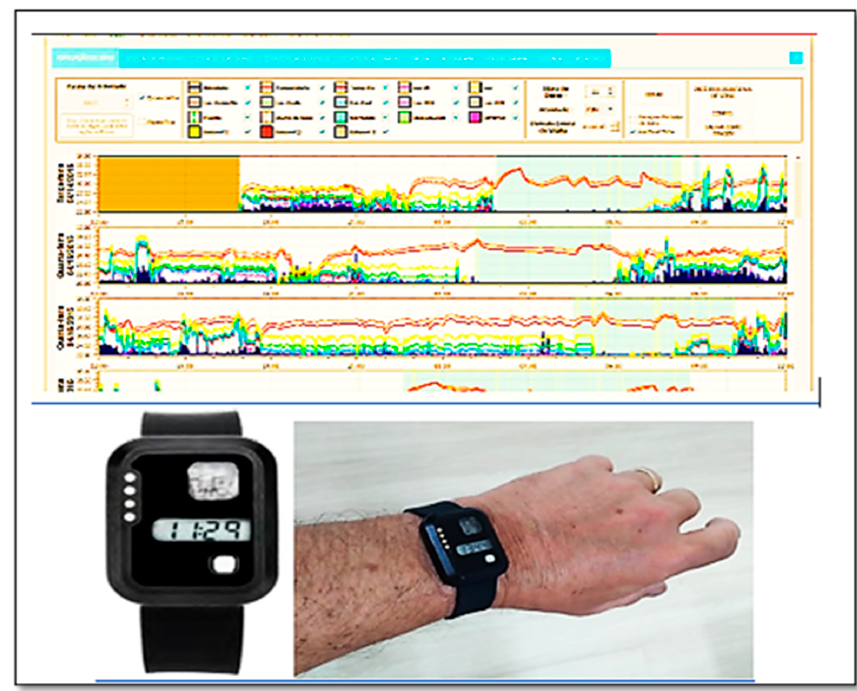
Figure 1. Wrist actigraph (ActTrust-2) on the left hand and sleep score graph display showing captured objective parameter data.